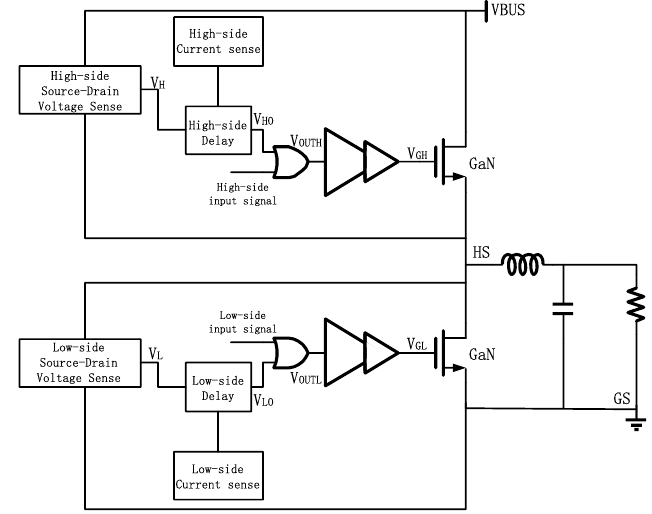
Figure 3. Adaptive dead-time control circuit.